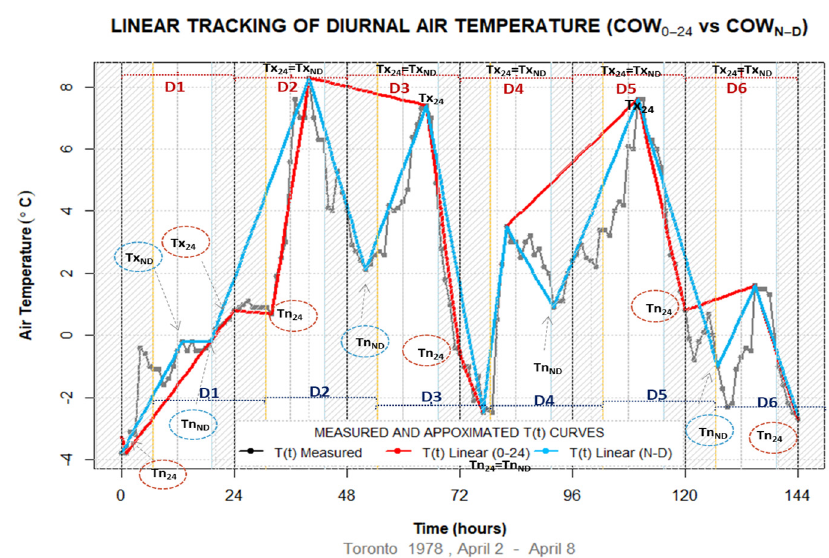
Figure 2. Comparison of COW 0–24 and COW N–D observing windows. Linear temperature tracking highlights the effect of the choice of a diurnal observing window on the accuracy of temperature extrema identification. Gray solid lines represent measured hourly temperature, while red and blue lines correspond to linearly interpolated temperatures based on COW 0–24 and COW N–D extrema. Hatched areas represent the duration of nighttime, while vertical yellow lines indicate sunrise. The COW 0–24 days extend between consecutive midnights (vertical black dotted lines), while COW N–D days extend between consecutive sunrises (vertical solid yellow lines).